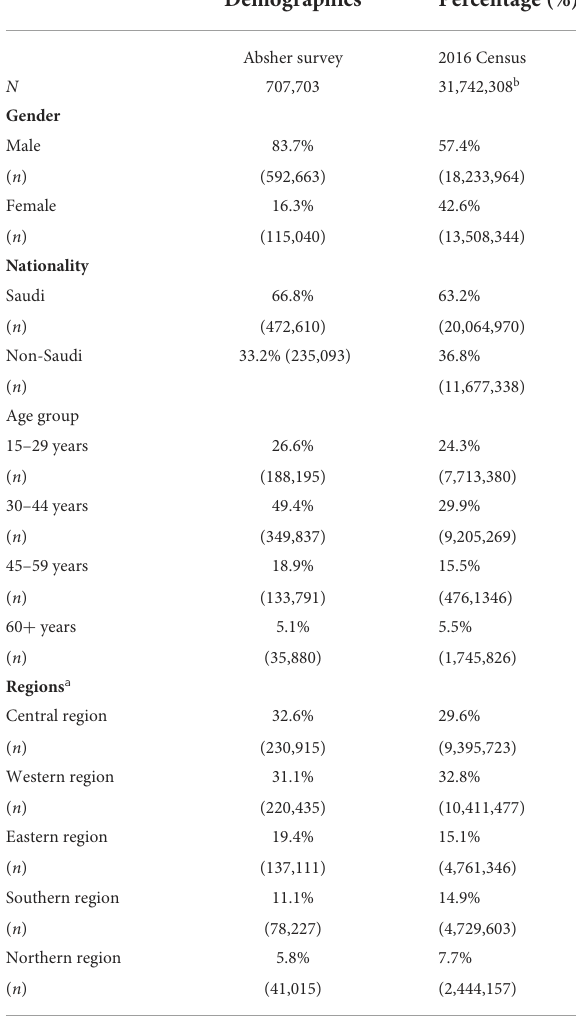
TABLE 1 Demographic characteristics of Absher survey respondents 2019–2020 compared to Saudi Arabia’s 2016